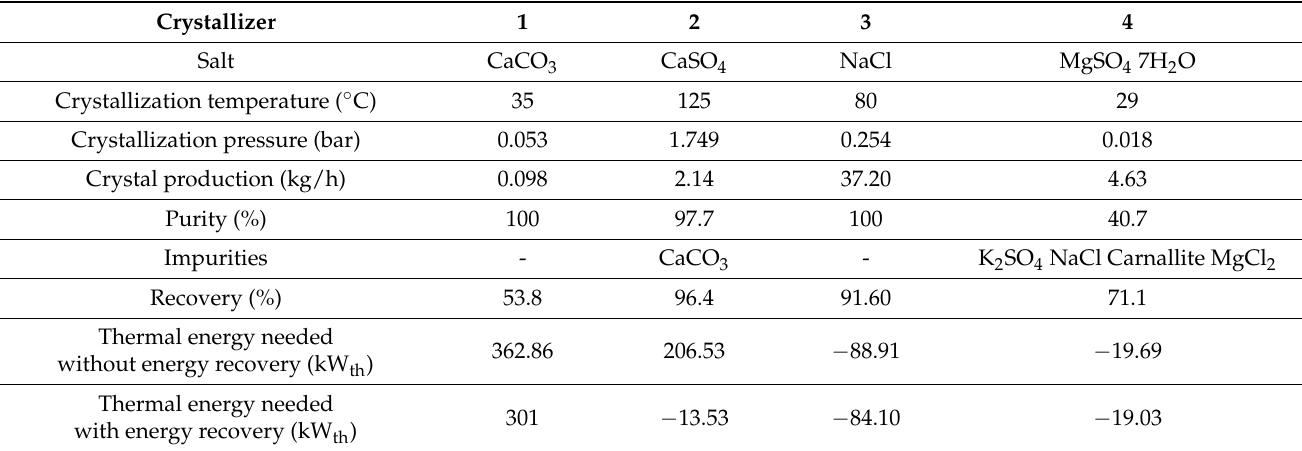
Table 8. Production results for the multi-crystallization system for 1,000 kg/h of feed